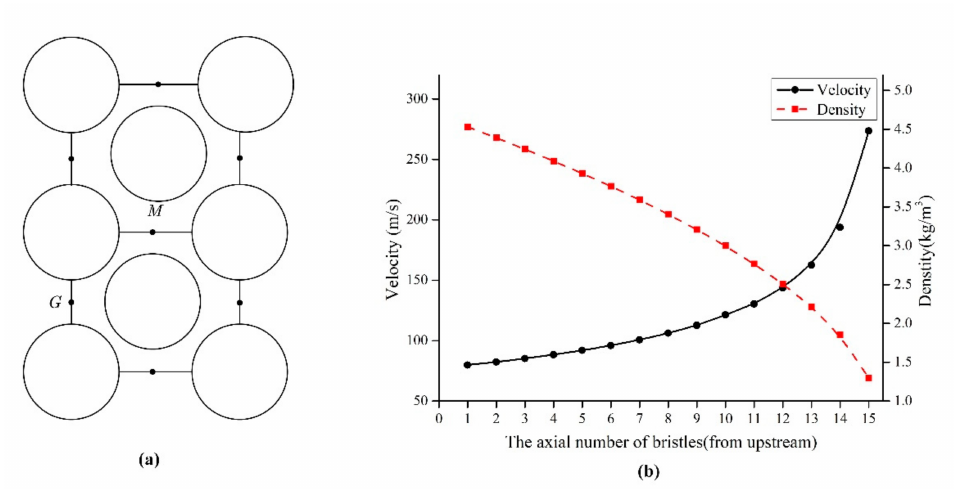
Figure 4. Data collection points ( a ) and the change of velocity and density ( b ) at ∆ P = 0.3 MPa and S D /d = 1.10, where the points of G and M are the data collection points in ( a ).